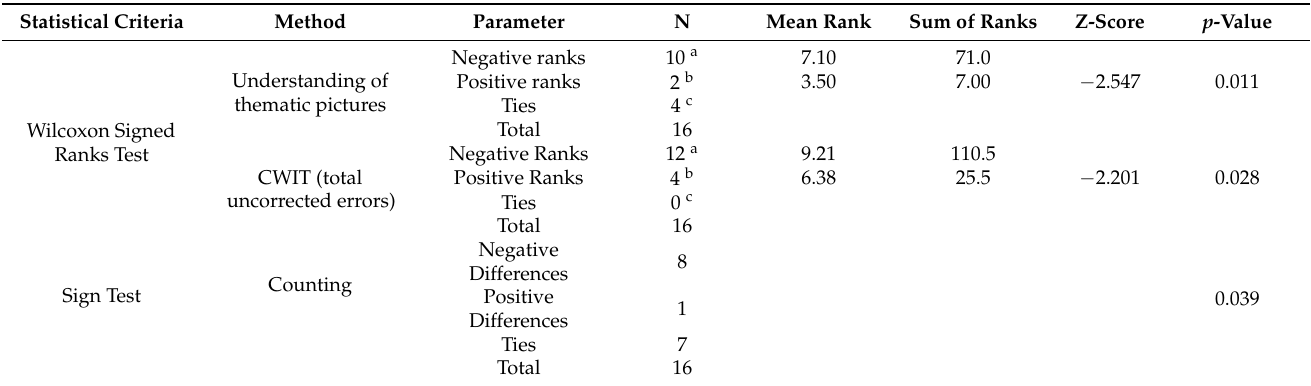
Table 4. Wilcoxon signed ranks test and Sign test results across methods which differed significantly before and after the training sessions ( p ≤